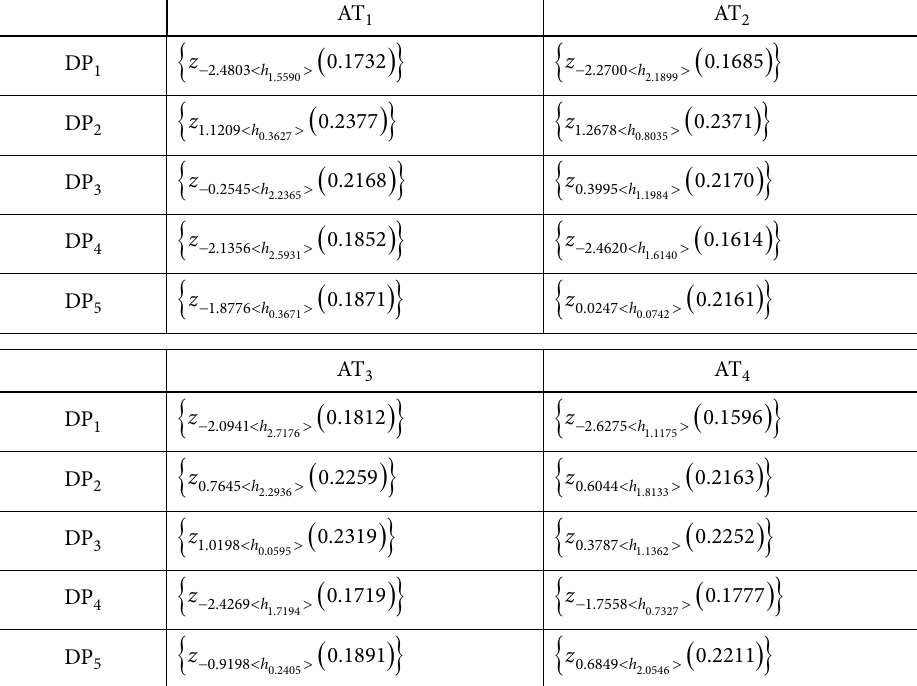
Table 11. The PDHLTSs decision information with prospects weight based on e